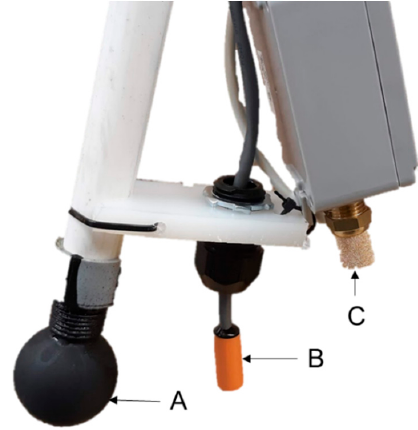
Figure 2. Thermal Environment Sensor Array (TESA) for microclimate instrumentation. Sensors are labeled: ( A ) black globe temperature (BGT); ( B ) dry-bulb temperature (DBT); ( C ) relative humidity (RH).